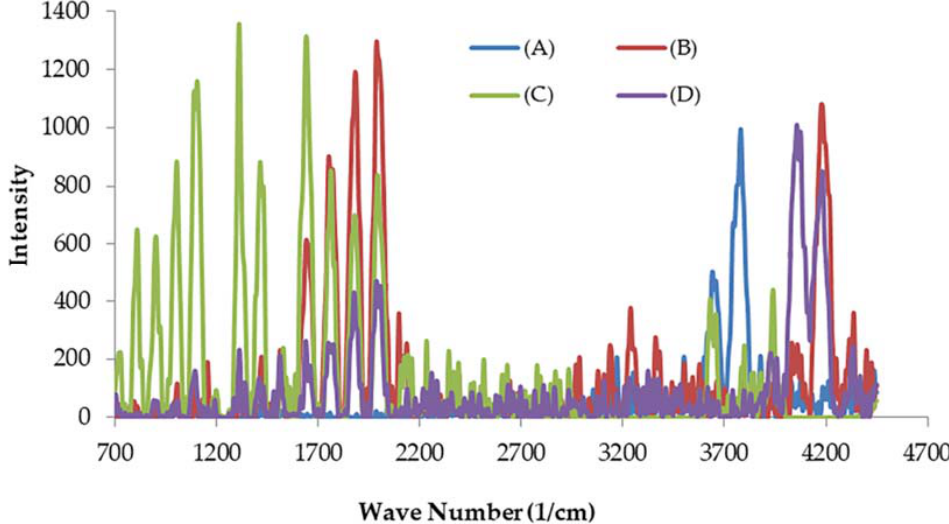
Figure 2. Raman spectrum for spectra for (A) ACDW before treatment, (B) ACDW after treatment, (C) LFB before treatment, and (D) LFB after treatment of ammonia.